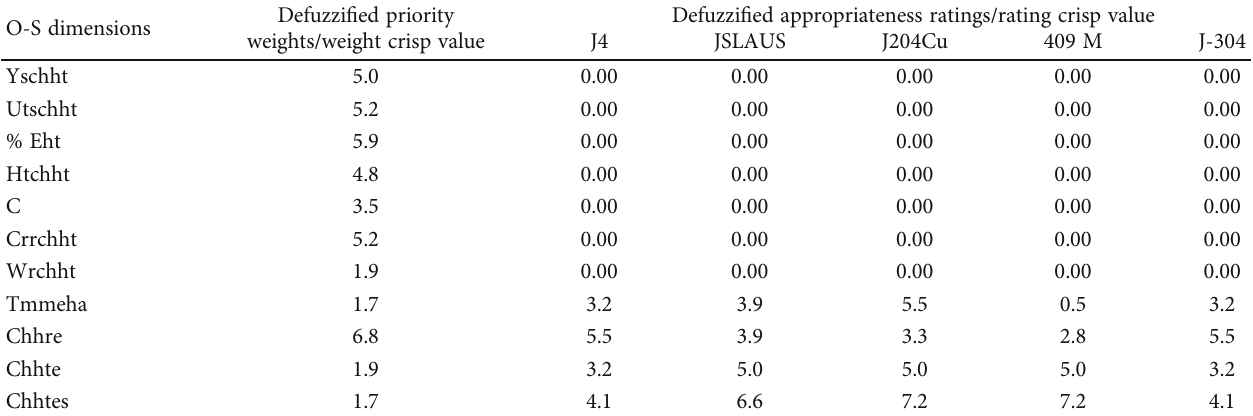
Table 6: Computed defuzzi fi ed crisp values of TEHES-O-S-tube material dimensions for assessing EAI.